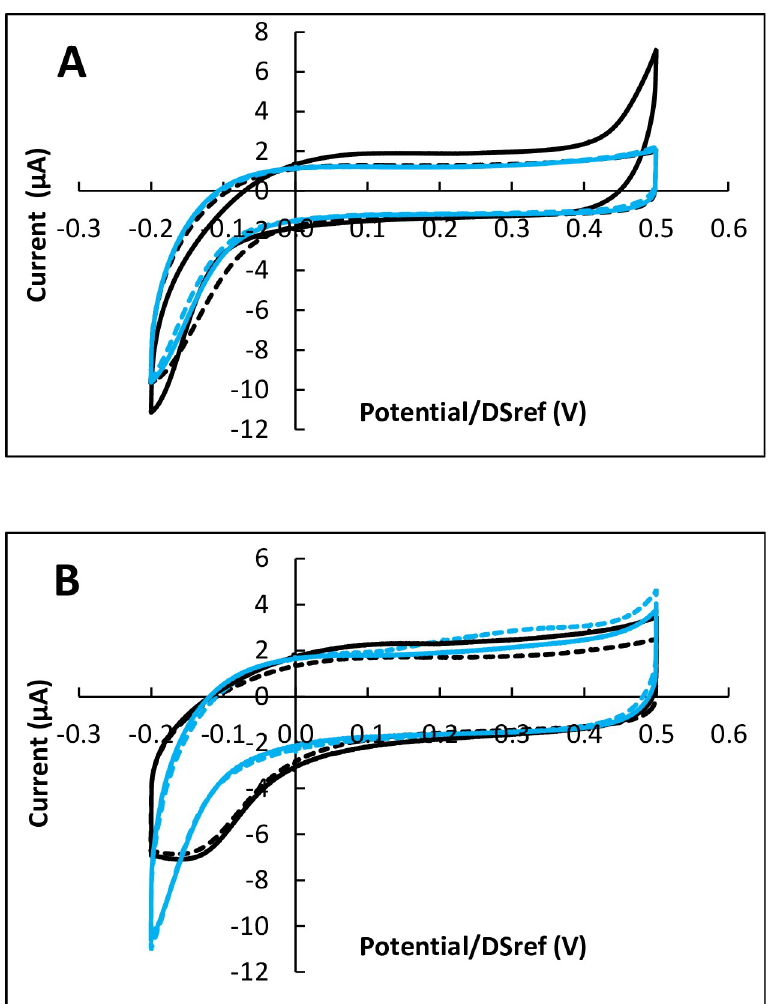
Fig 3. Cyclic voltammetry of Vero cells on CNT-coated carbon electrodes after 48 and 72 hours of incubation. Potential scan rate 10 mV.s -1 . A) 48 hours, B) 72 hours. Black: with cells; blue: controls without cells; in each case dotted lines are duplicates. Potentials are expressed vs. the DropSens pseudo-reference (DSref), values vs. SHE can be obtained by adding 0.290